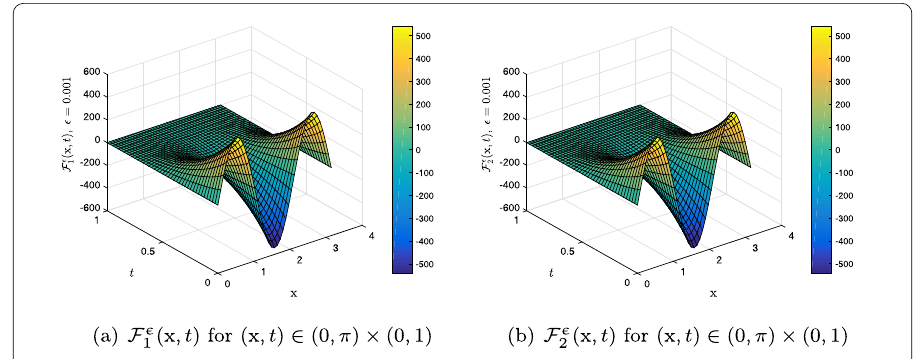
Figure 4 The source functions F ε 1 ( x , t ) = F 1, ε ε = 0.001, α = β = 0.9